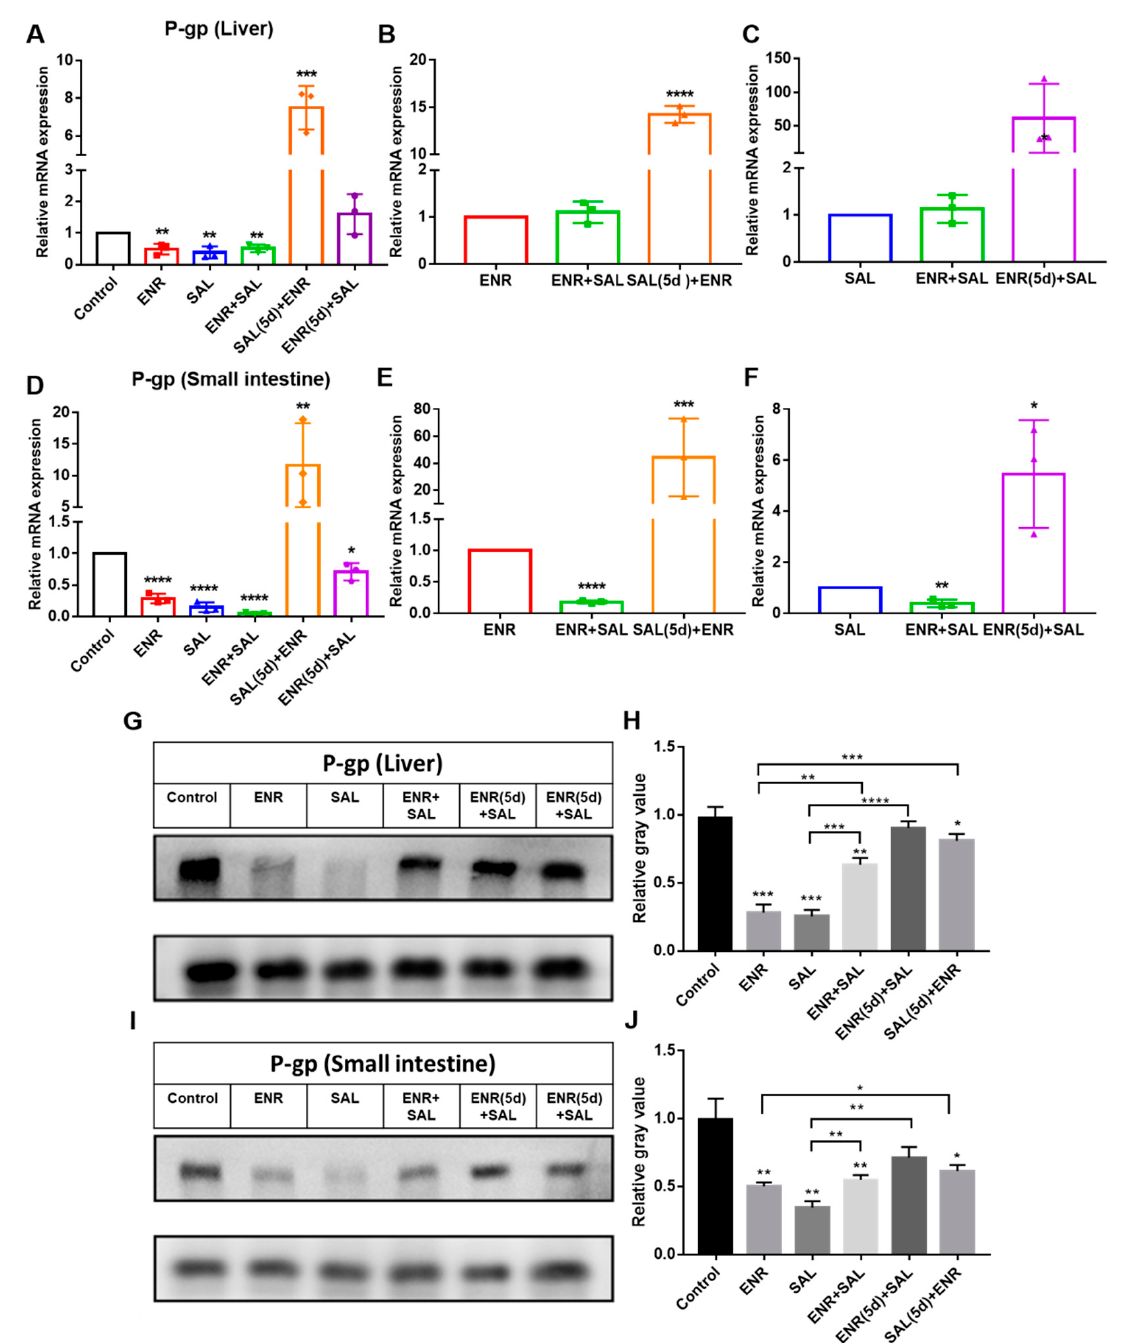
Figure 5. Effects of ENR and SAL on P-gp gene expression levels in liver and small intestine. ( A – C ) are expression in liver, ( D – F ) are expression in small intestine. ( B , E ) are the effects of single ENR as control group, single combined administration group (ENR + SAL) and continuous 5d SAL group (SAL (5d) + ENR) on the expression level of P-gp. ( G , I ) are protein expression in liver and small intestine, respectively. ( H , J ) are gray value levels of figure ( G ) and ( I ), respectively. ( C , F ) are the effects of single SAL as control group, single combined administration group (ENR + SAL) and continuous 5d ENR group (ENR (5d) + SAL) on the expression level of P-gp. * on the error bar of each group indicates the difference from the control group. * means p < 0.05; ** means p < 0.01; *** means p < 0.005; **** means p <